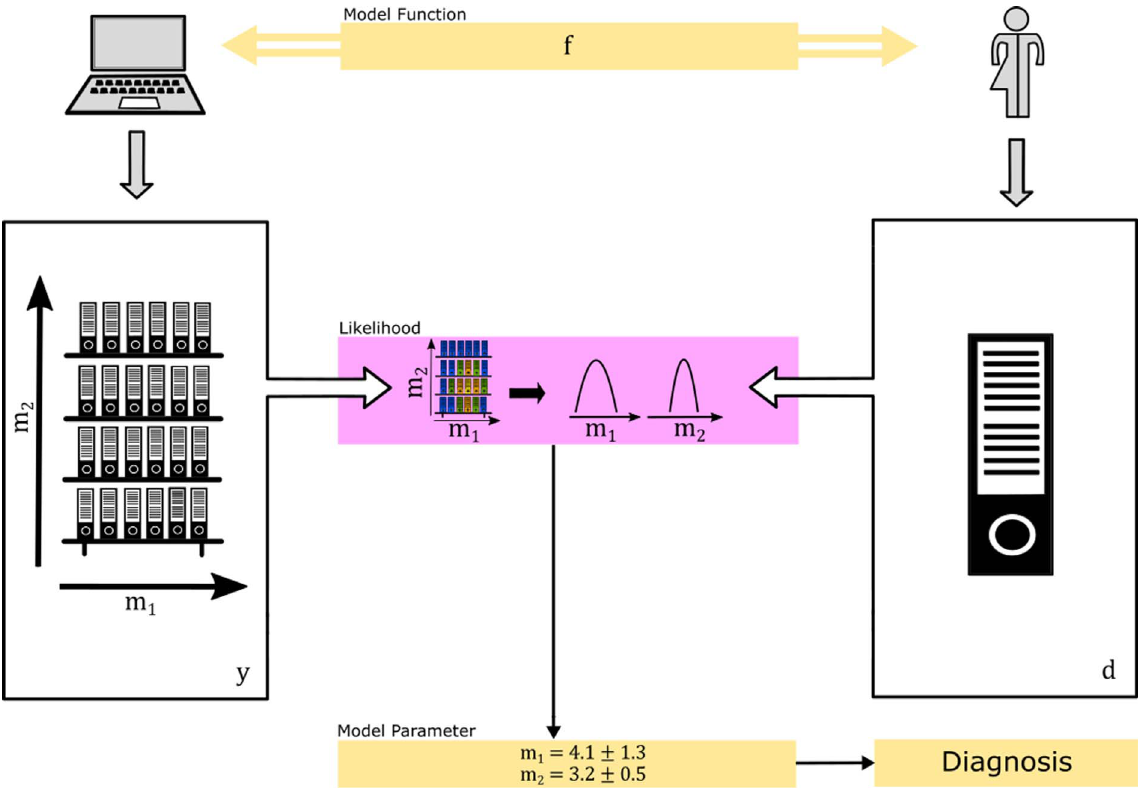
Figure 1. General approach for the model-based diagnostics using a likelihood procedure. The model function is used to generate the look-up table y, and it is assumed that this function works in a same way as the subject. The subject data is obtained experimentally. For illustration, a folder represents all data from either a subject or from a speci fi c model instance. All possible combinations of model parameters make up the folder shelf, representative of the model table y . Consider that for the respective folder, each new measurement generates a new sheet of paper containing the stimulus information and the response. The goal is to fi nd the model instance (folder) that has the maximum likelihood of having generated the experimental data. The resulting likelihood surface (left side of purple rectangular) has the same dimension as the folder shelf. In addition to the likelihood of each instance, con fi dence intervals can be calculated for each model parameter, which represent the model-based